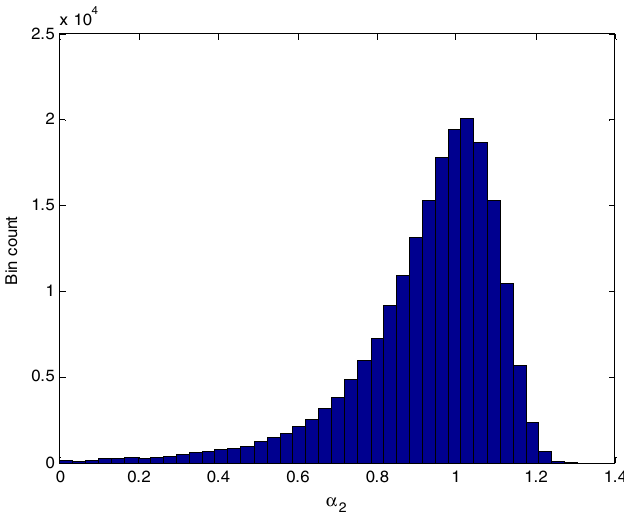
Fig. 5. Histogram of the samples for α 2 for noisier data. Figure 4 represents the nonlinear correlation